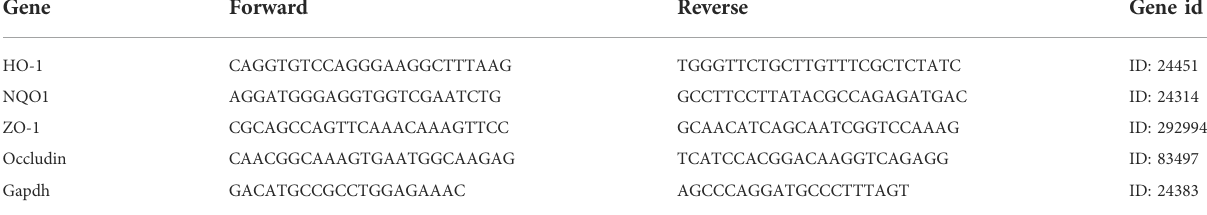
TABLE 3 The PCR primers sequences for RT-qPCR(Rat).